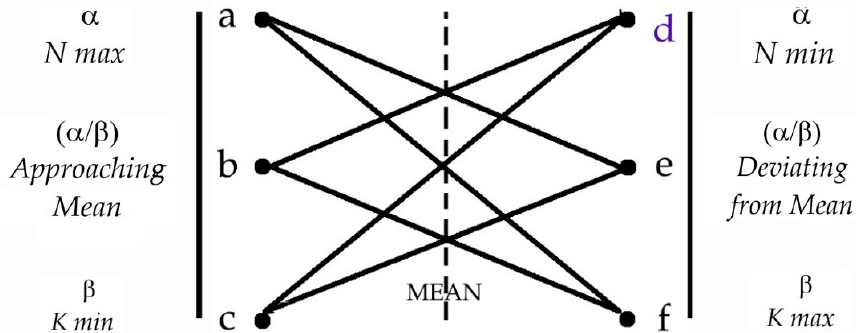
Figure A1. Mapping search experience in GRAPHYP: a–f are the six typical modelizable cliques combining triplets of nodes that are included in a cognitive community [7].